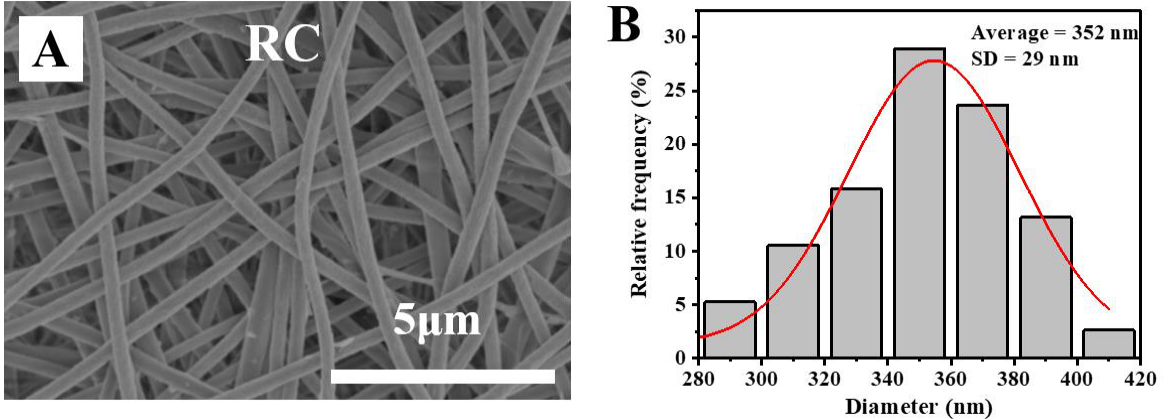
Figure 5. ( A ) SEM image of the electrospun RC nanofiber membrane and ( B ) its size distribution.